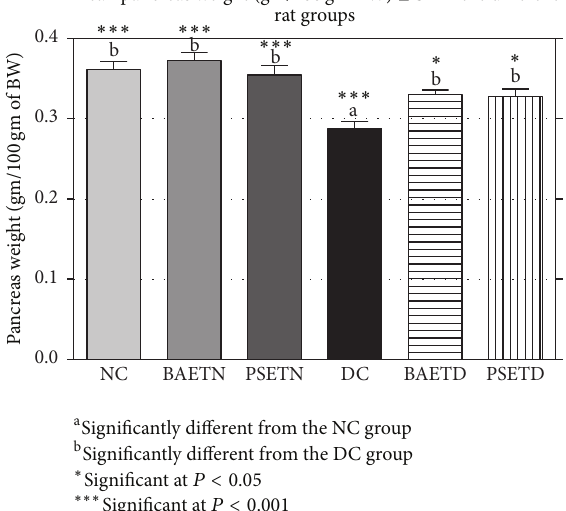
Figure 6: Oral administration of either Balanites aegyptiaca fruit aqueous extract or Petroselinum sativum leaf aqueous extract to the diabetic rats produced a significant ( 𝑃 < 0.01 ) decrease in their mean plasma MDA levels when compared with the diabetic control rats.